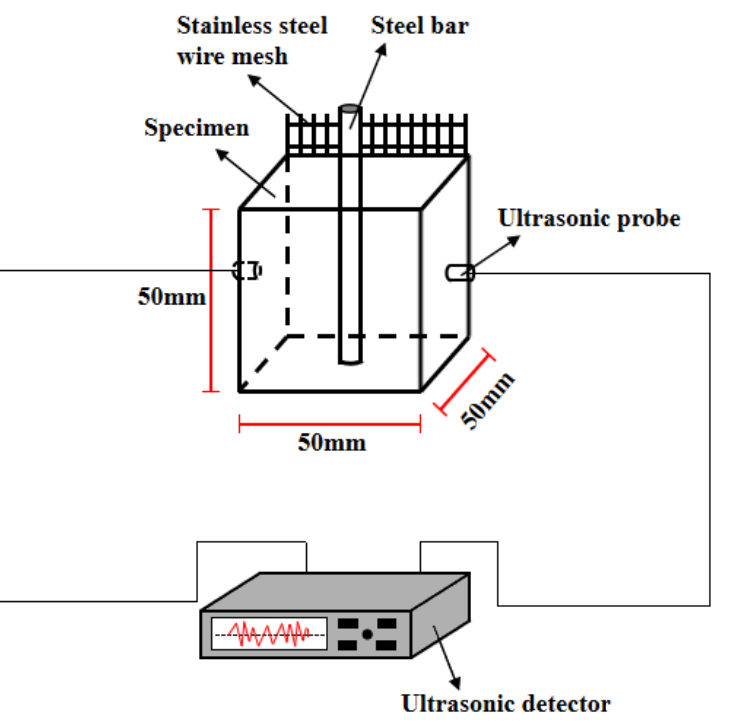
Figure 1. The ultrasonic velocity measurement.